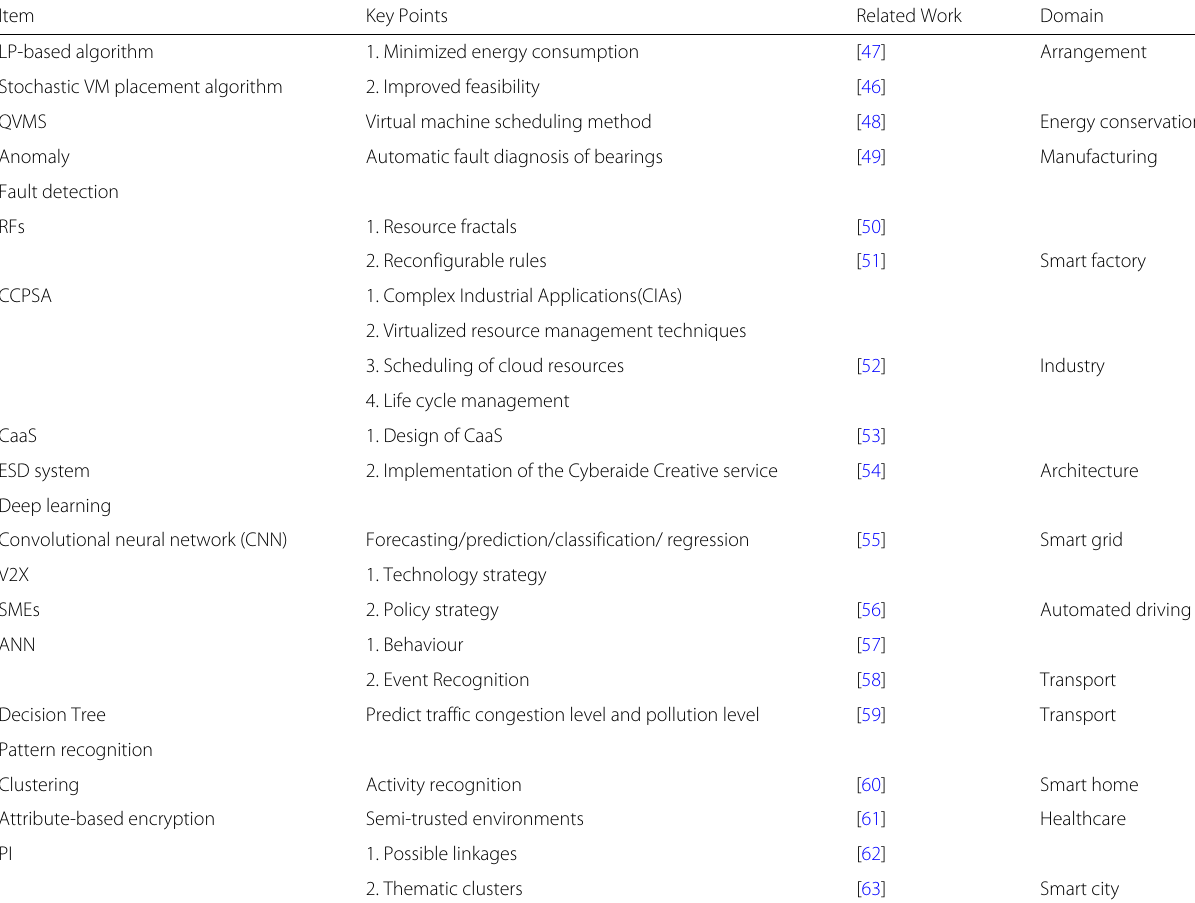
Table 3 Summary of Literatures about Methods on Cloud Computing Based CPS Item Key